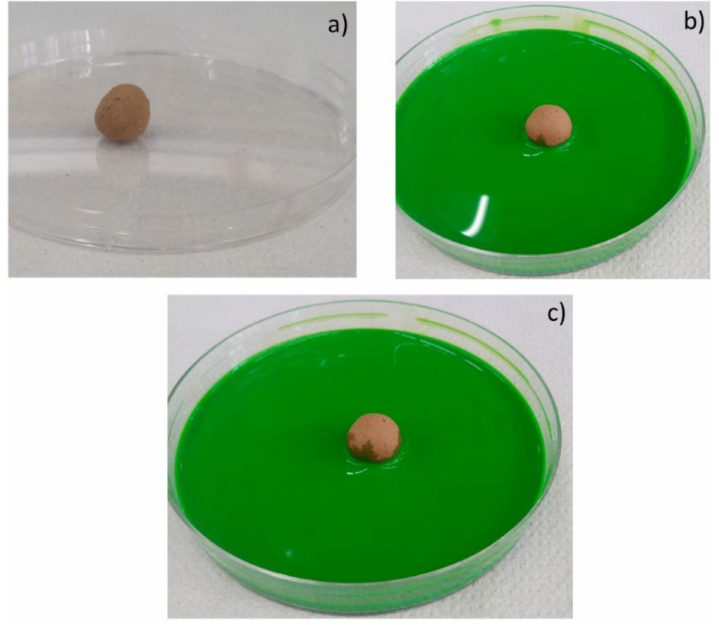
Figure 11. Images of manual pelletized samples (PE.FG30) before the contact with green ink ( a ); 2 s ( b ) and 2 min ( c ) after the contact with green ink.